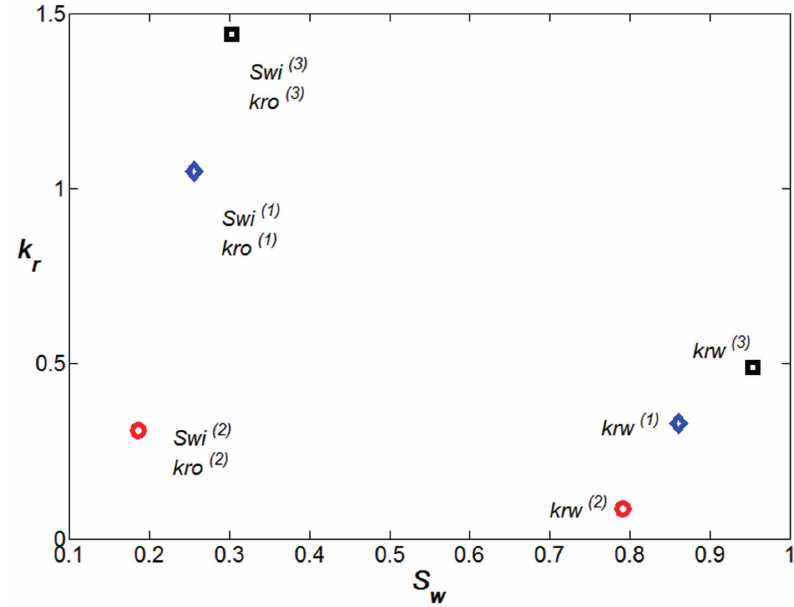
) versus water saturation ( S ) for the three r w